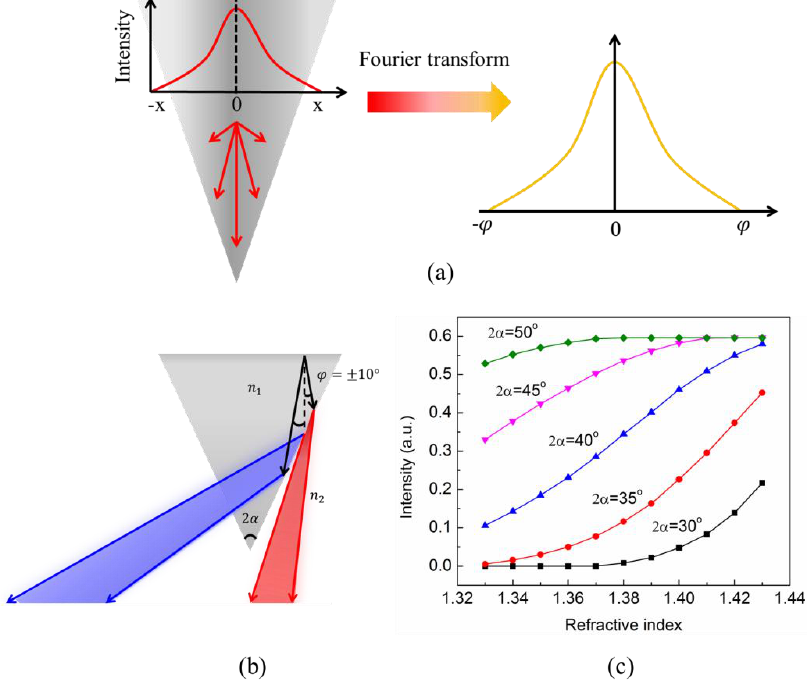
Figure 2. ( a ) Incident light in the fiber tip region can be transformed as different amplitude’s planar waves in various propagation directions; ( b ) the incident light propagates through the interface between the axion tip and the surrounding solution, plane waves (red part) can directly transmit to the solution at a lower divergence. Planar waves (blue part) with incident angles larger than the critical angle are emitted from the fiber tip at large divergent angles; and ( c ) the changes of the collected intensities (red part) for different axicon angles and various environmental refractive indices. These measurements were always performed with the same collection optics.